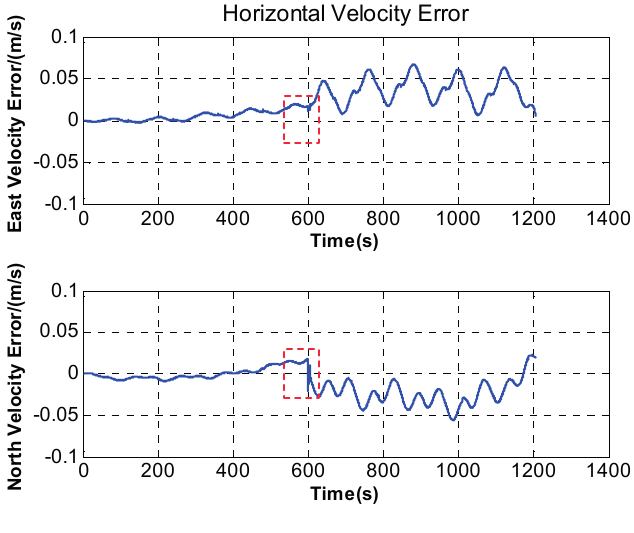
Figure 6. Comparison of original and modulated azimuth angle error of RINS.